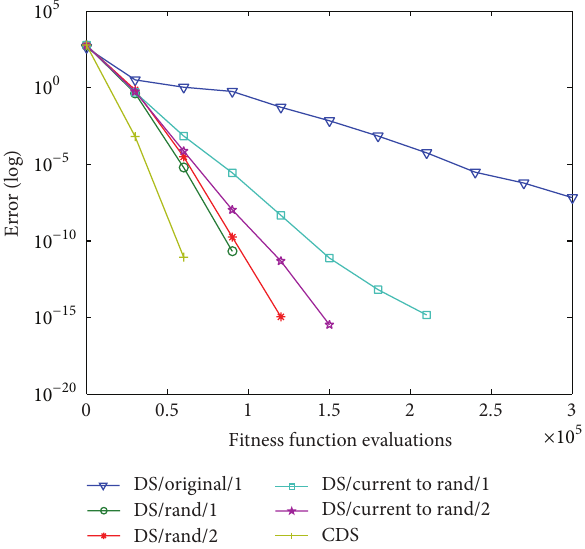
Figure 8: Comparison of performance of six algorithms for mini- mization of 𝑓 09 with dimension 30.